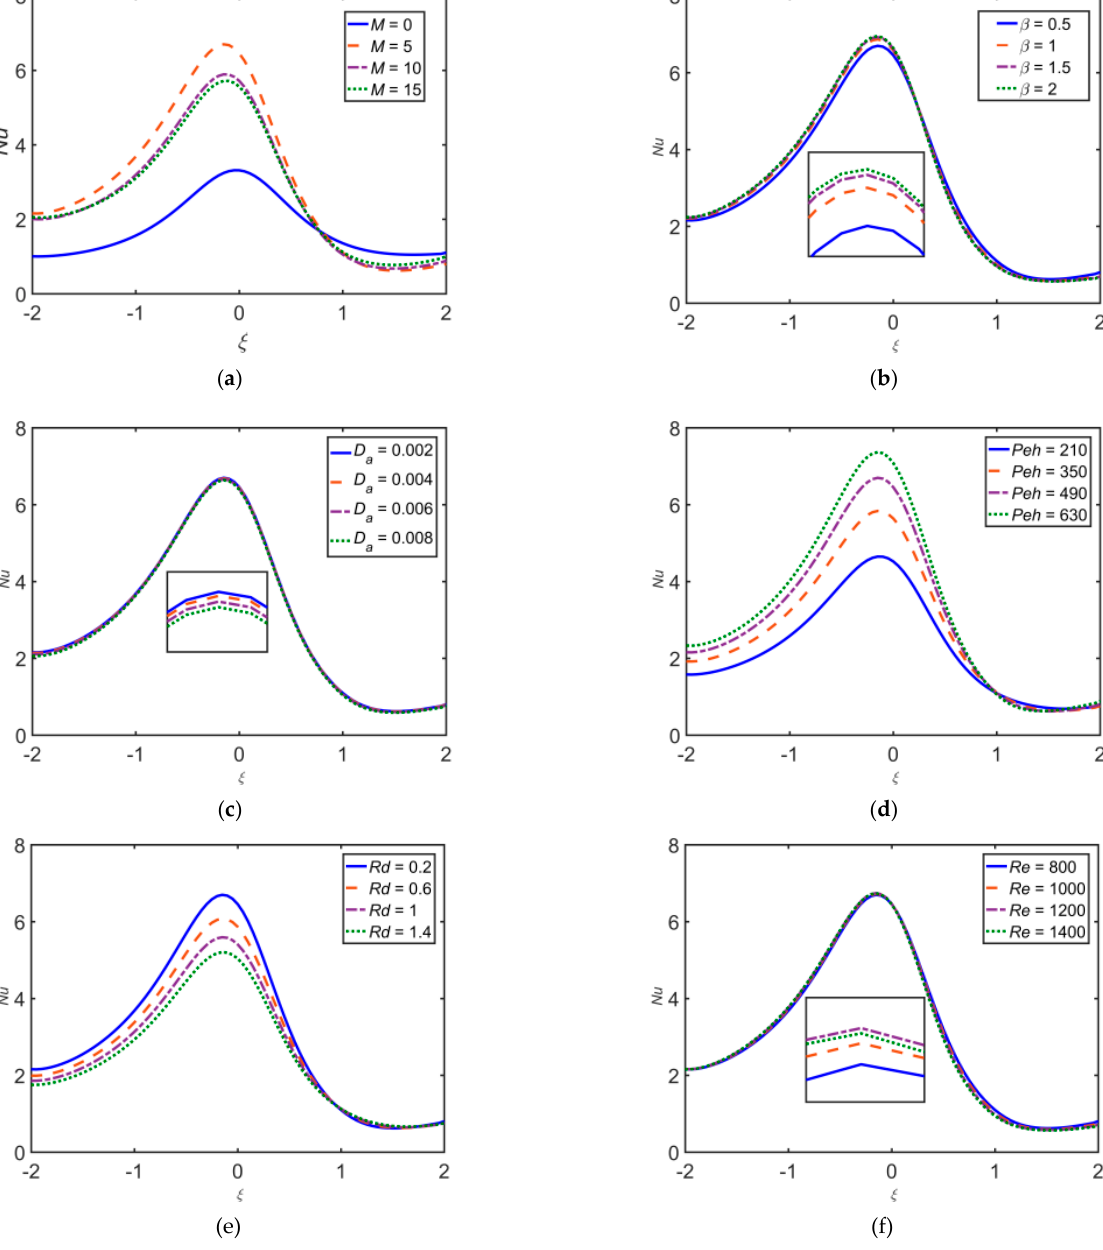
Figure 14. Impact of ( a ) M , ( b ) β , ( c ) D a , ( d ) Peh , ( e ) Rd , and ( f ) Re on Nu . Figure 15 depicts the influence of different flow governing parameters on the Sher- wood number Sh . It is observed that Sh escalates as β , Rd , Re , and Pem estimations intensify, whereas Sh reduces upon escalating D a , M , Peh , and Sr .